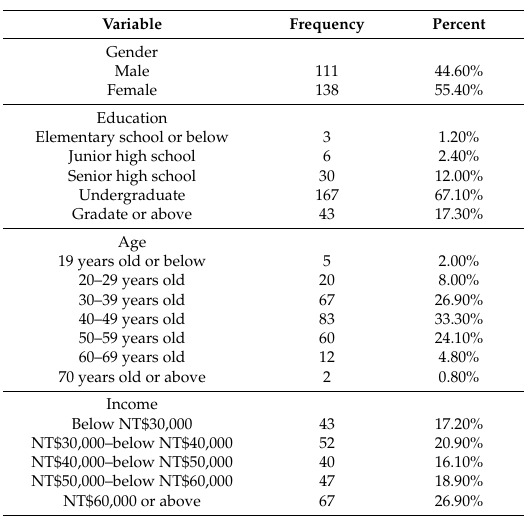
Table 3. Demographic profiles of respondents in Study 2 ( n =